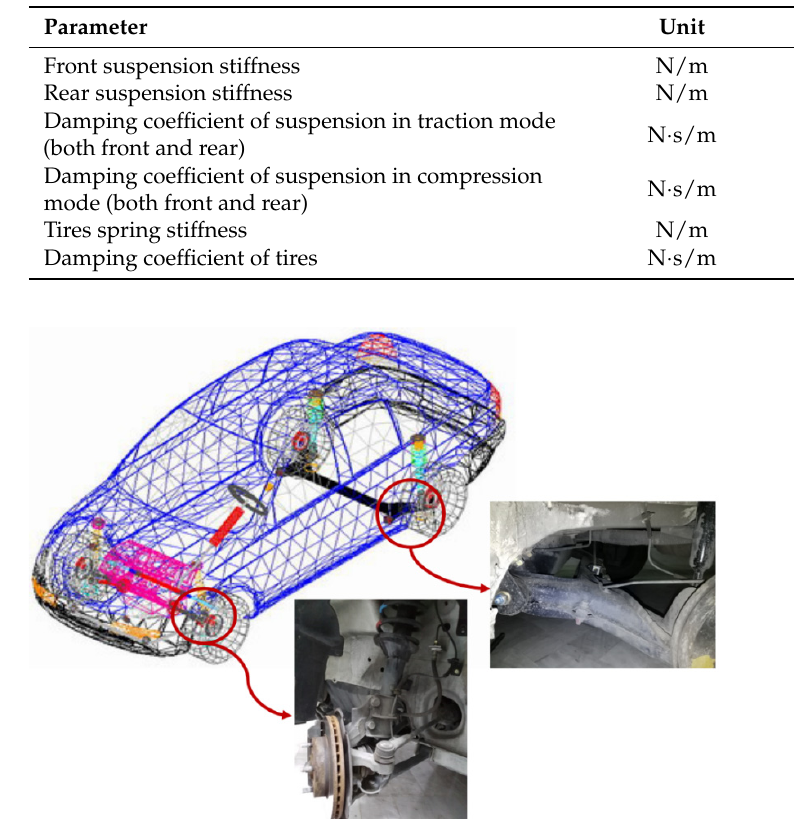
Figure 4. Full vehicle model in Adams/Car Software based on reality [56].